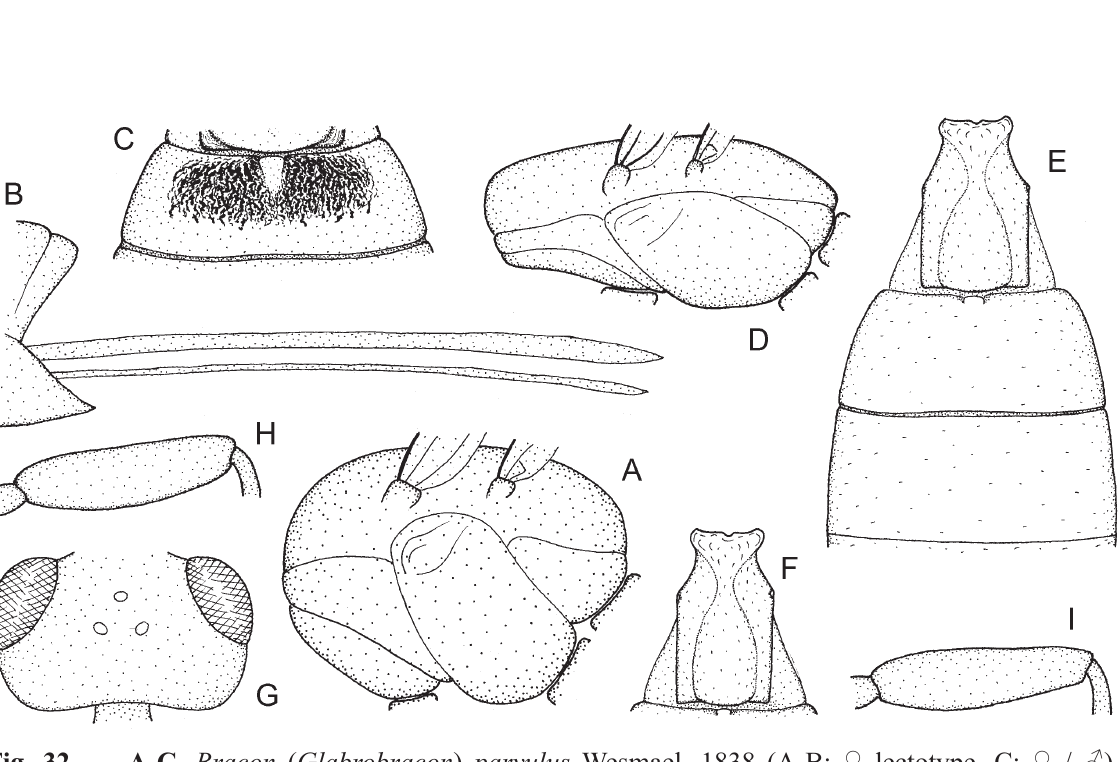
Fig. 32. — A-C . Bracon ( Glabrobracon ) parvulus Wesmael, 1838 (A-B: ♀ lectotype, C: ♀ / ♂). A . Mesosoma. B . Hind end of metasoma: hypopygium and ovipositor sheath. C . Second tergite. — D-I . Bracon ( Glabrobracon ) longulus Thomson, 1894 (D-E, G-H: ♀ lecotype, F, I: ♀ / ♂). D . Mesosoma in lateral view. E . Tergites 1-3. F . First tergite. G . Head in dorsal view. H-I . Hind